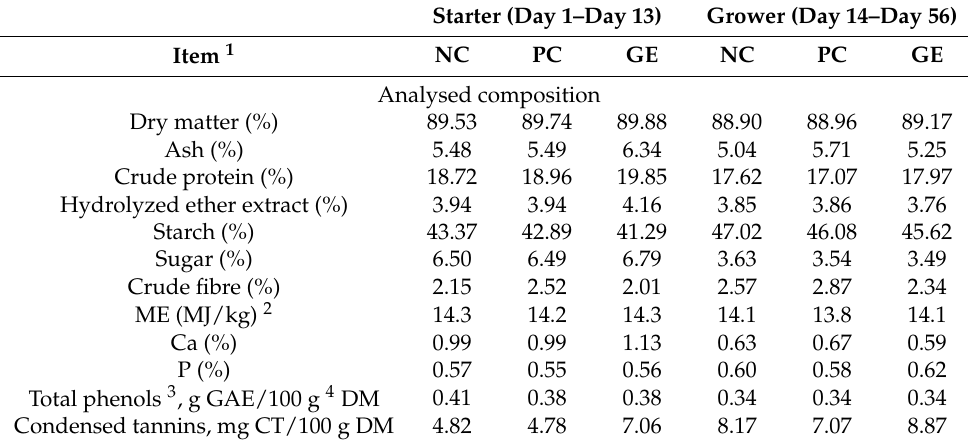
Table 2. Analyzed nutrient concentration in all diets (as-fed) in starter and grower